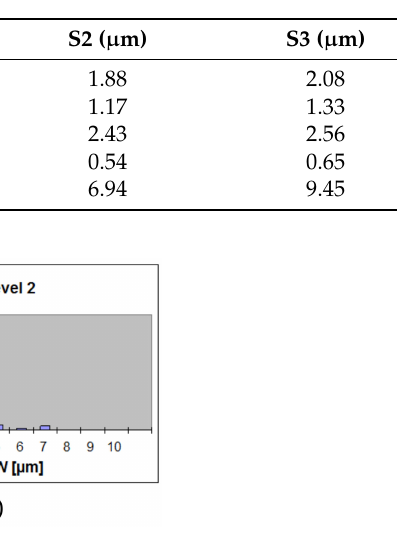
Table 1. Results of Talyrond measurement of the cylinders [34].